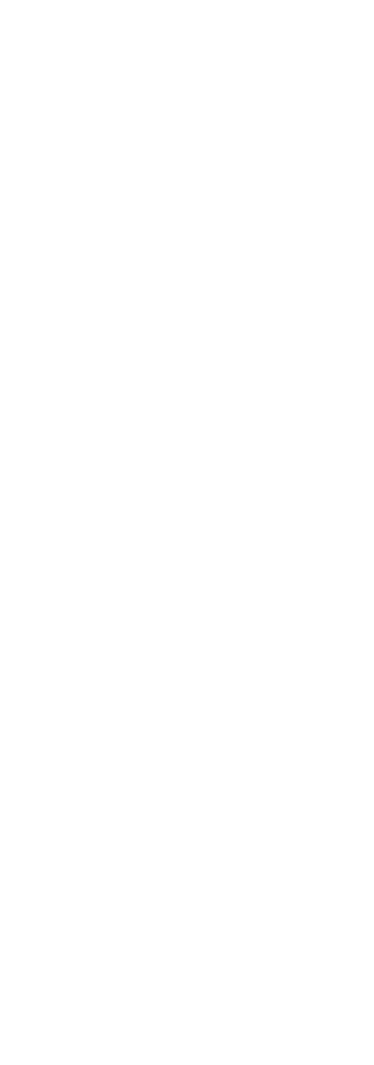
FIGURE 3 Lack of correlation between cytokine + T-cell and humoral responses in MS patients treated with anti-CD20. Spearman ’ s correlation between IFN g + (green), IL-2 + (red) and IFN g + /IL-2 + (yellow) T-cell response and the relative anti-RBD IgG OD values of aCD20-MS patients (n=42). r coef fi cient and P value are included for each correlation. The bold, continuous line indicates the regression line and the vertical dotted line highlights limit of sensitivity for antibody